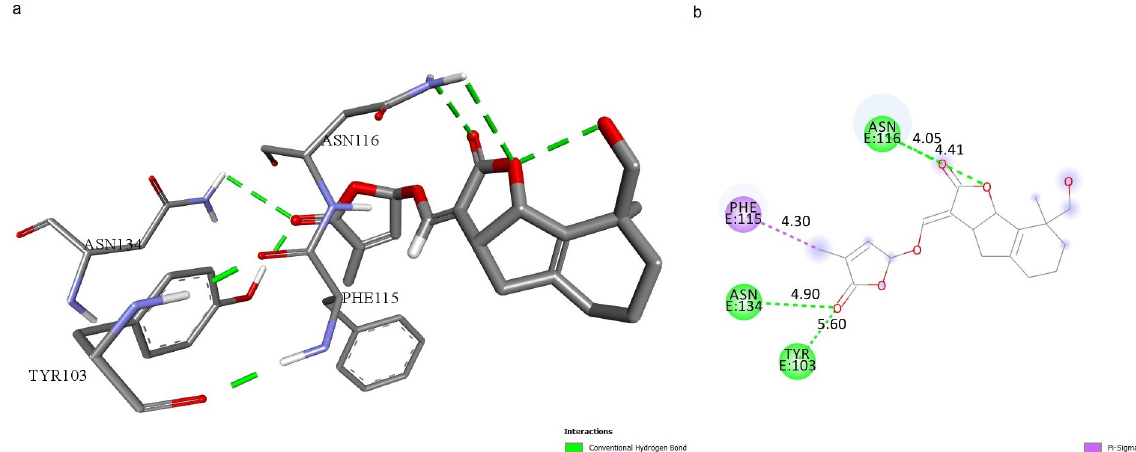
Fig 2. mTNF α -hTNFR1 interaction with Strigol. a .3D shape of mTNF α -hTNFR1 interaction with Strigol. b . Illustration of hydrophobic bond formation between Strigol and the mTNF α -hTNFR1 complex. Strigol forms 3 hydrogen bonds with ASN116, ASN134, and TYR103, and 1 π -sigma bond with PHE115 of